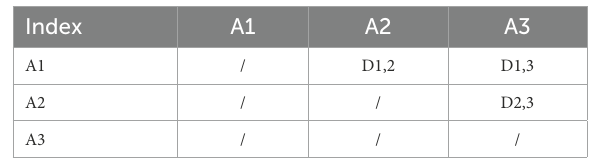
TABLE 7 Scores of importance.